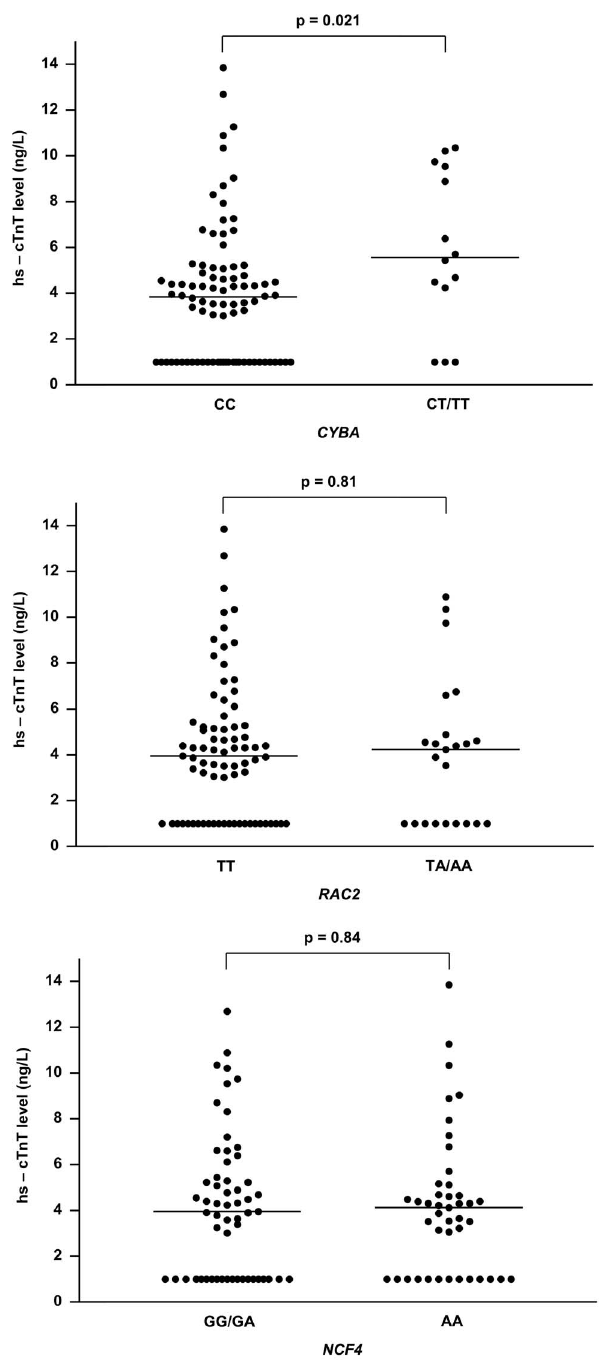
Figure 2. Levels of high sensitivity cardiac troponin T (hs-cTnT) in survivors by NAD(P)H oxidase and multidrug resistance protein polymorphisms. Scatter plots showing distributions of hs- cTnT levels in relation to (a) CYBA , (b) RAC2 , and (c) NCF4 polymorphisms. Solid lines represent median hs-cTnT levels. doi:10.1371/journal.pone.0077063.g002 The association between polymorphism of the CYBA rs4673 and higher hs-cTnT levels is intriguing. The CYBA gene codes for p22- phox, a subunit that that forms the NAD(P)H oxidase multien- zyme complex. The T allele at position 242 leads to a missense mutation His72Tyr. A gene dose-dependent reduction of stimu-